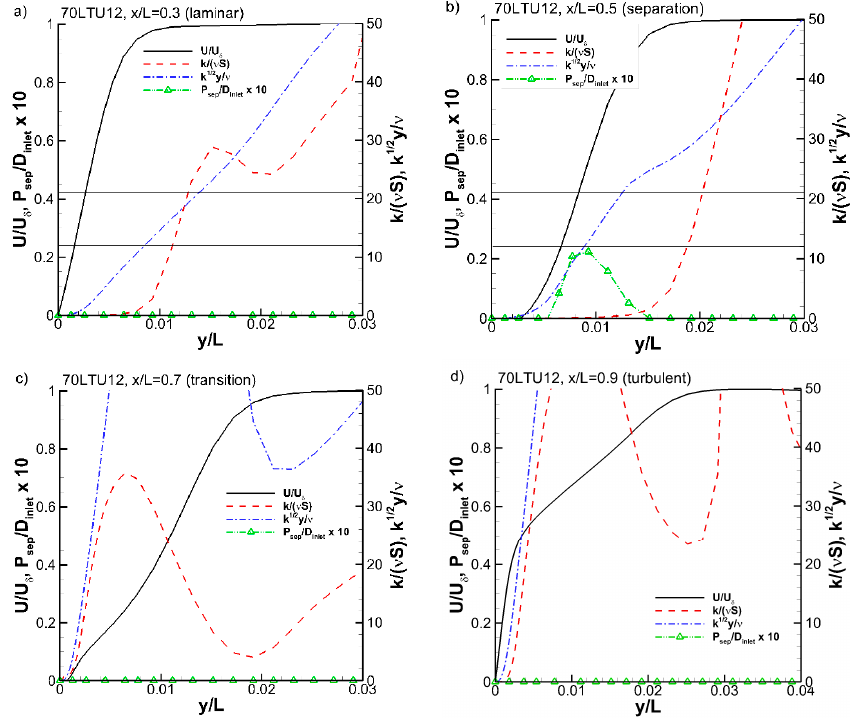
Figure 2. Functioning of the transition model in a separated boundary layer.